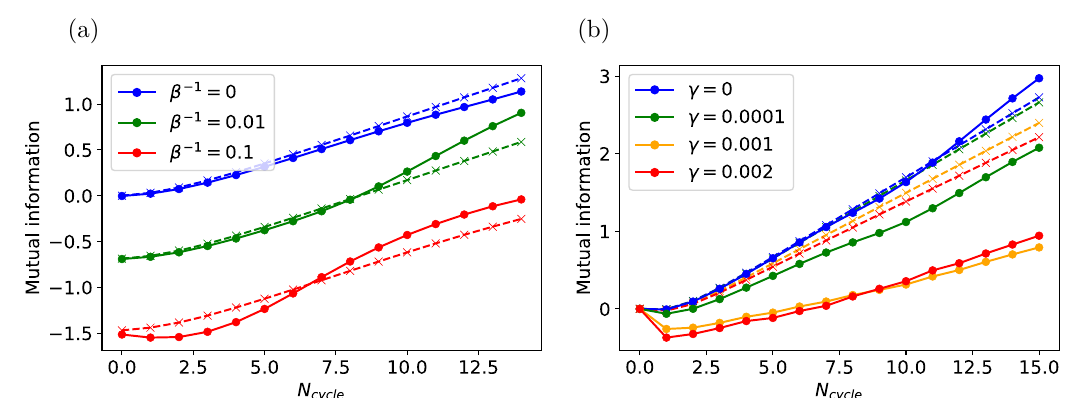
Figure 11: (a) Growth of half-system mutual information I ([ 0, L / 2 ] , [ L / 2, L ]) for / L = 0.95, T / L = 0.05 (full lines), T / L = − 0.05, T / L = 0.05 (dashed lines), T 0 1 0 1 and different initial temperatures. The equilibrium value of half-system mutual infor- mation in the ground state has been subtracted. (b) Growth of half-system mutual in- / L = 0.9, T / L = 0.1 (full lines), T / L = − 0.1, formation I ([ 0, L / 2 ] , [ L / 2, L ]) , for T 0 1 0 / L = 0.1 (dashed lines), and different dissipations γ T 1